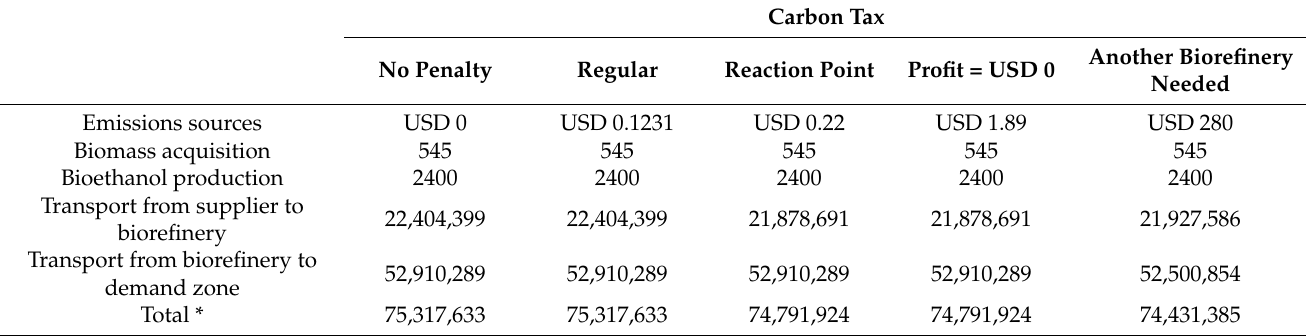
Table 6. Emissions from different sources by carbon tax with a 300 MGPY demand